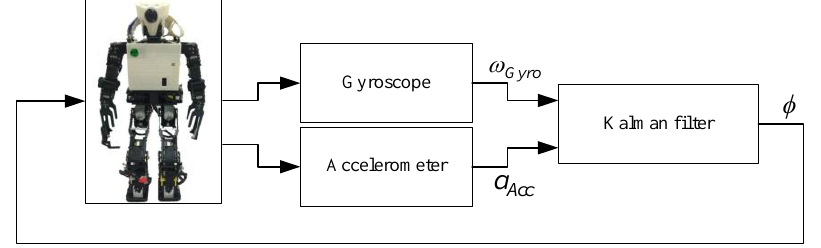
Figure 5. Block diagram of Kalman filter used for TKU-X.